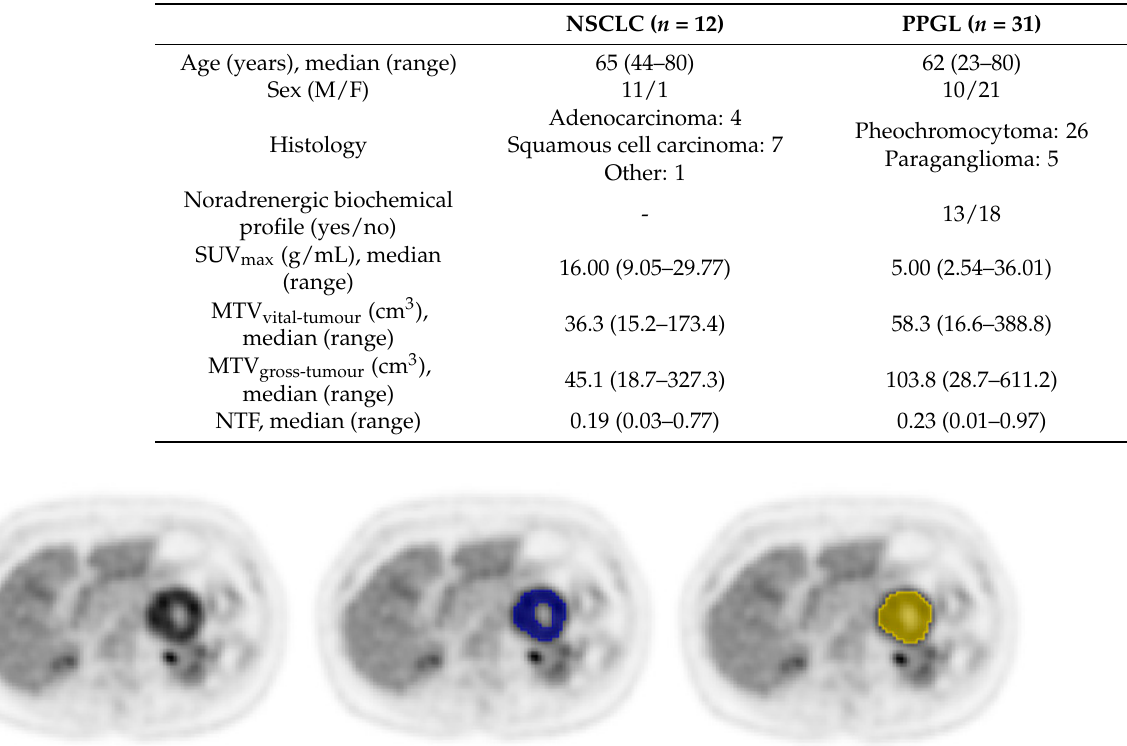
Figure 1. Example of a [ 18 F]FDG PET/CT scan of a patient with a pheochromocytoma with central necrosis in the left adrenal gland, with VOI vital-tumour in blue and VOI gross-tumour in yellow. The NTF is 0.05. Table 1. Clinical characteristics of 31 PPGL and 12 NSCLC patients with central necrosis. SUV: standardised uptake value, MTV: metabolic tumour volume, NTF: necrotic tumour fraction, NSCLC: non-small cell lung carcinomas, PPGL: pheochromocytomas and paragangliomas.